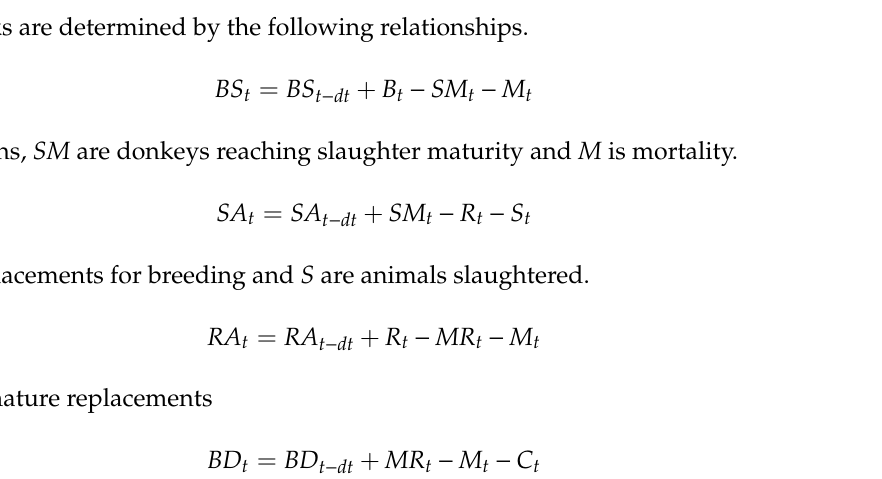
Figure 3. User interface of the donkey farming model.